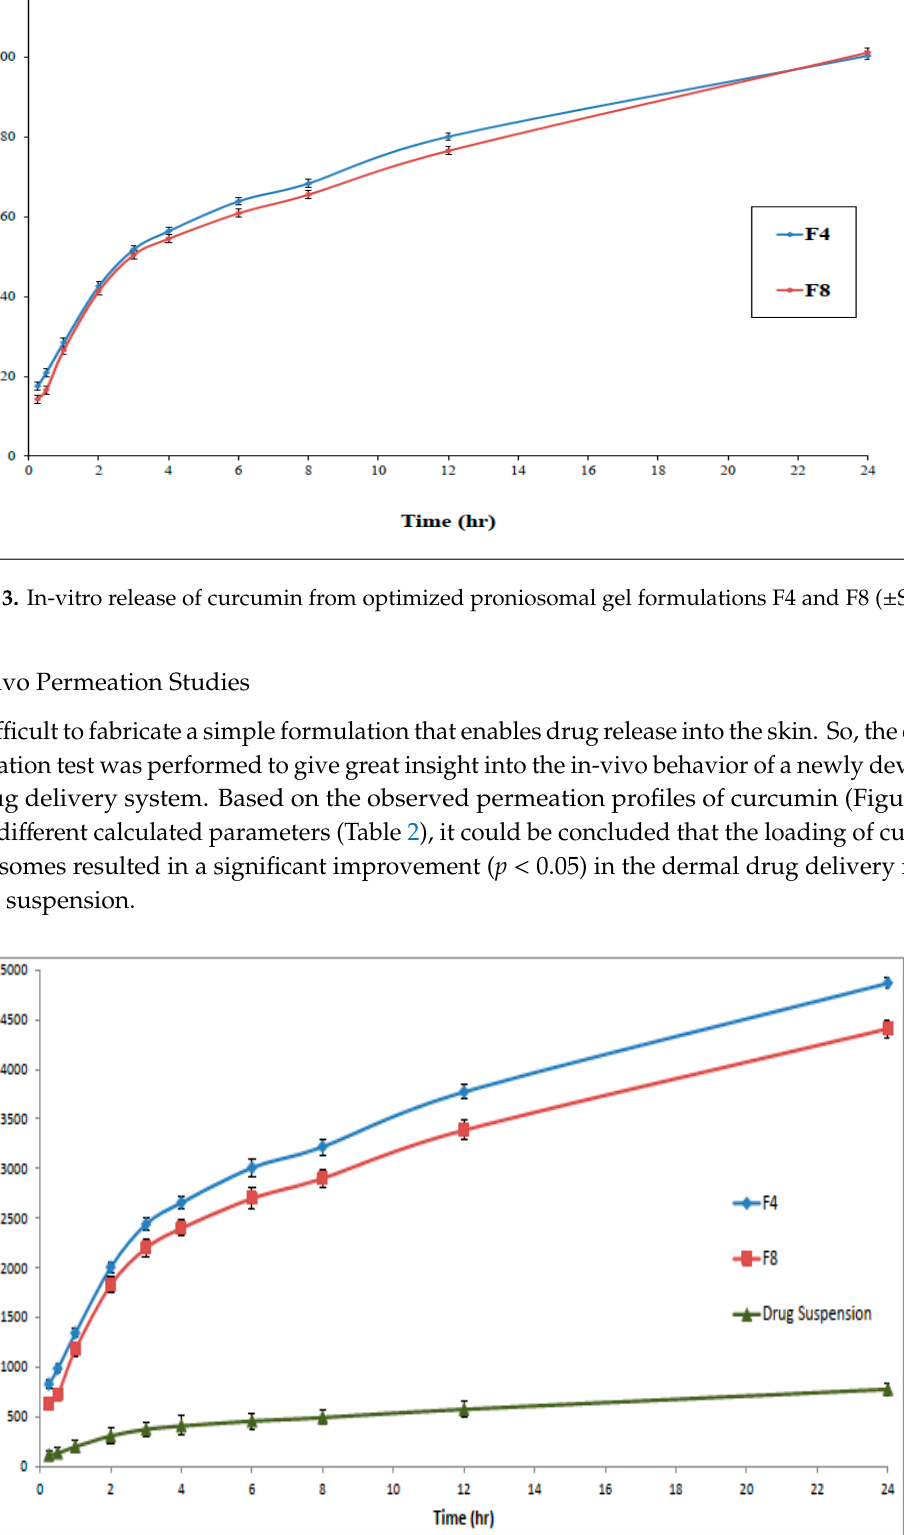
Figure 4. Amount of curcumin permeated at different time intervals across the rat skin membrane from optimal formulae (F4 and F8) compared to the drug suspension (± SD, n = 3).